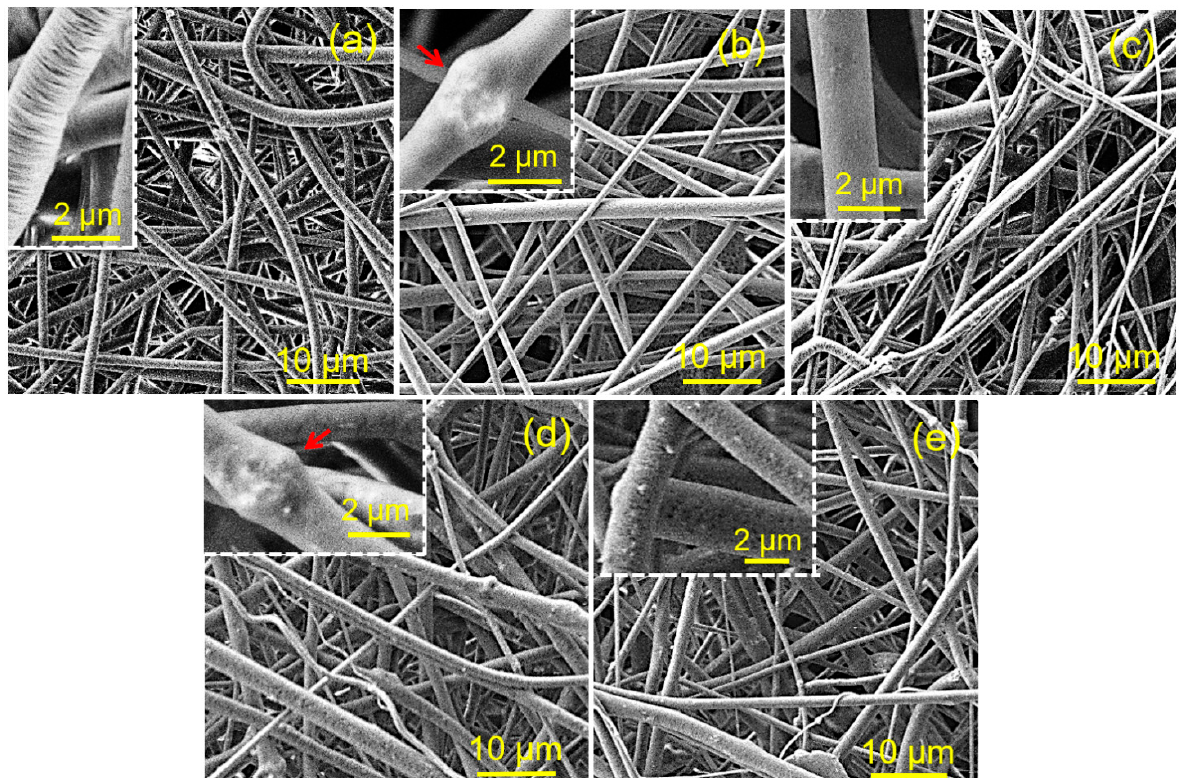
Figure 10. SEM micrographs of electrospun PLA fibers ( a ), PLA/ACP ( b ), PLA/ACP ps ( c ), PLA/cHAp ( d ), PLA/cHAp ps ( e ). Nanoparticles aggregates are pointed out with yellow arrows. Insets show magnified images. Arrows show nanoparticles aggregates.